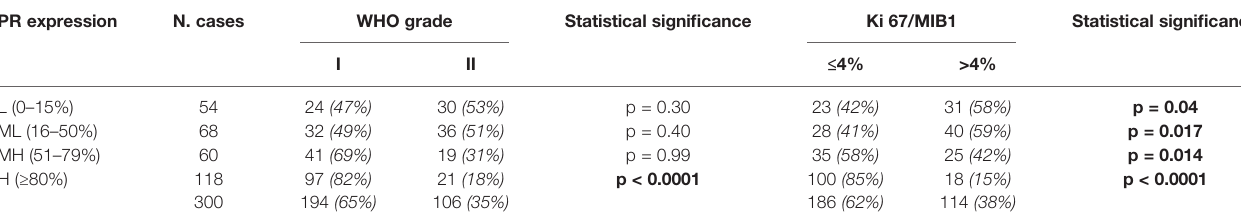
TABLE 5 | PR expression, WHO grade and Ki67/MIB1.